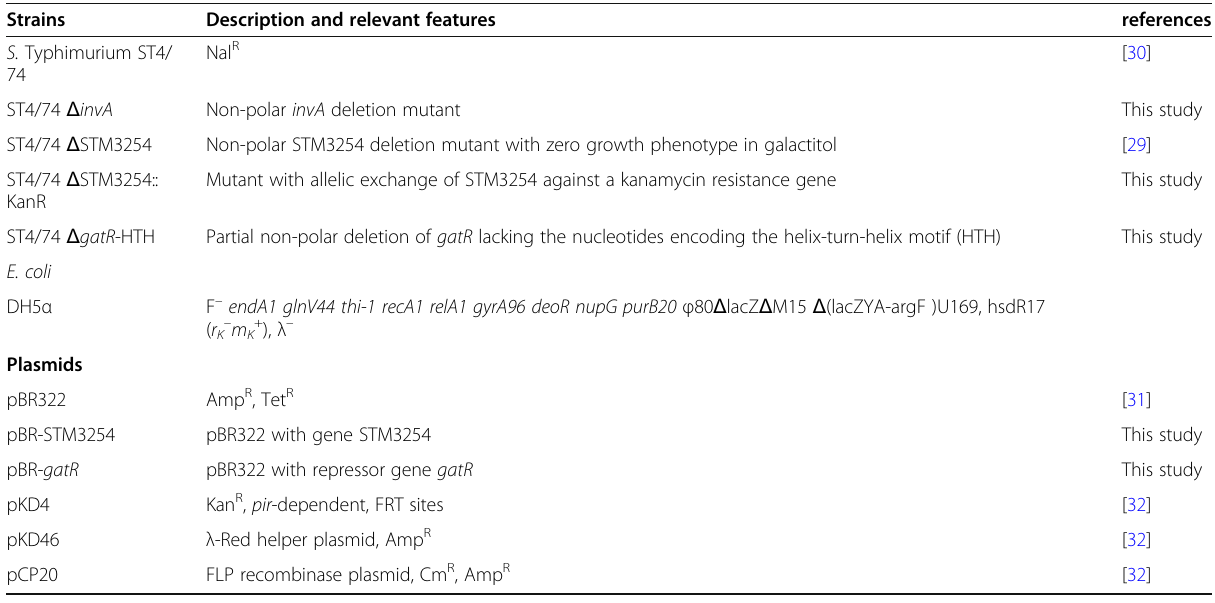
Table 2 Strains and plasmids used in this study Strains Description and relevant